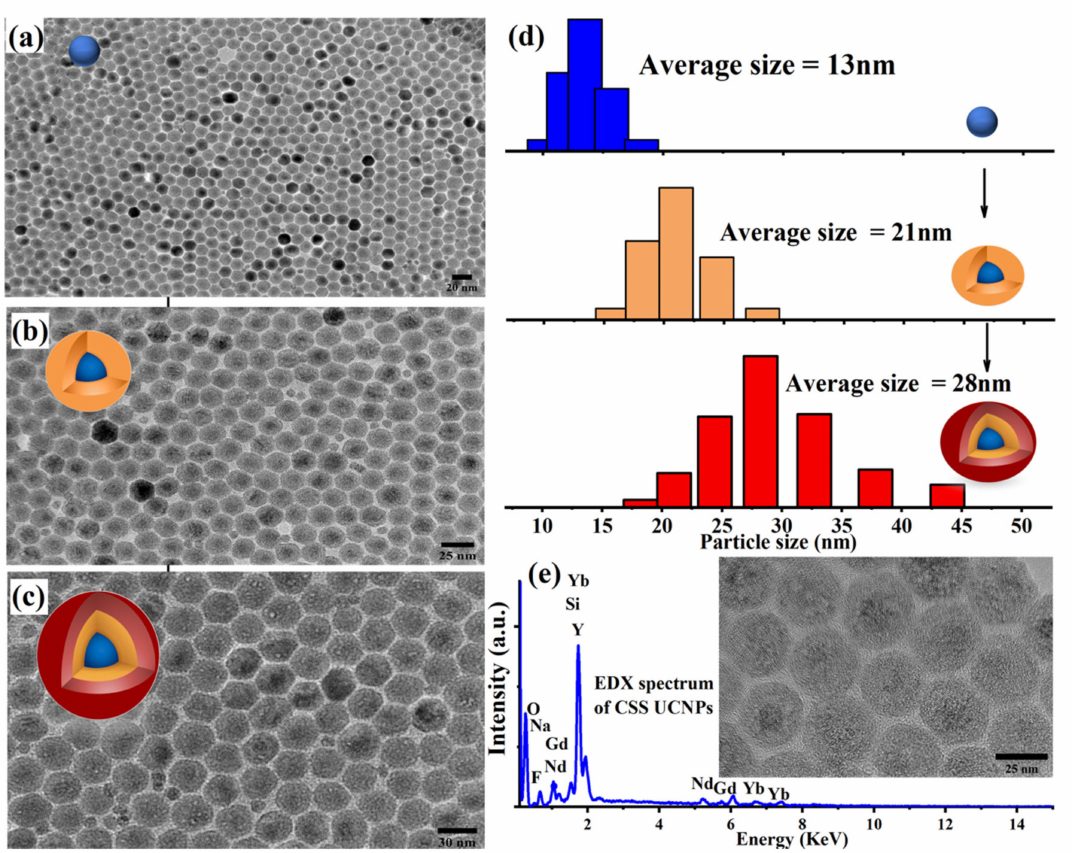
Figure 2. ( a – c ) Structural characterization of the core–shell–shell NaGdF 4 :Yb (20%), Er (8%)@ NaGdF 4 :Yb (20%), and Er (8%). (a) TEM images of the C particles NaGdF 4 :Yb (20%), Er (8%). ( b ) TEM images of the CS particles NaGdF 4 :Yb (20%), Er (8%)@ NaYb 0.90 F 4 :Yb (10%), and Er (10%). ( c ) TEM images of the CSS particles NaGdF 4 :Yb (20%), Er (8%)@ NaYb 0.90 F 4 :Yb (10%), and Er (10%)@ NaYF4. ( d ) Corresponding DLS size distributions of the core–shell–shell UCNPs at different synthesis stages. (e, inset) A high resolution TEM image of the CSS UCNPs. ( e ) EDX spectrum recorded from the synthesized CSS